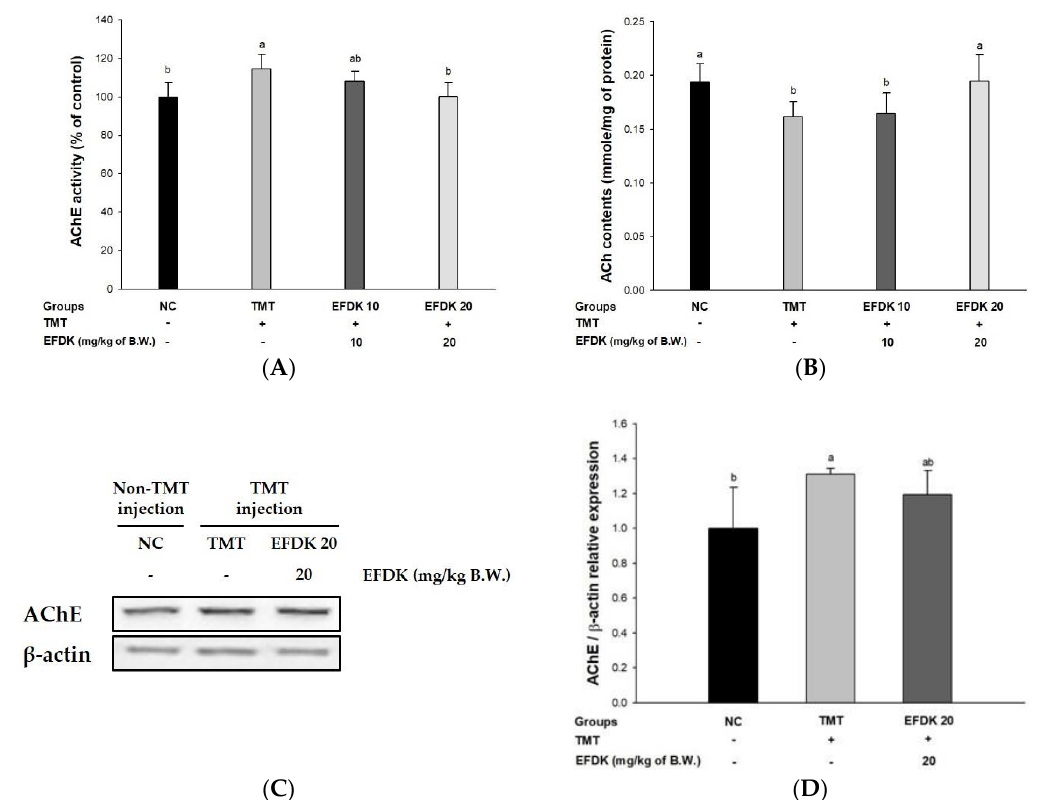
Figure 6. Protective effect of ethyl acetate fraction from persimmon (EFDK) on TMT-induced cholinergic dysfunction. ( A ) AChE activity; ( B ) ACh level; ( C ) representative western blots for total protein and expression of AChE; ( D ) protein expression levels of AChE normalized to β-actin. Results shown are mean ± SD (( A , B ), n = 8; ( C , D ), n = 3). Data were statistically represented at p < 0.05, and different small alphabets mean statistical significance.